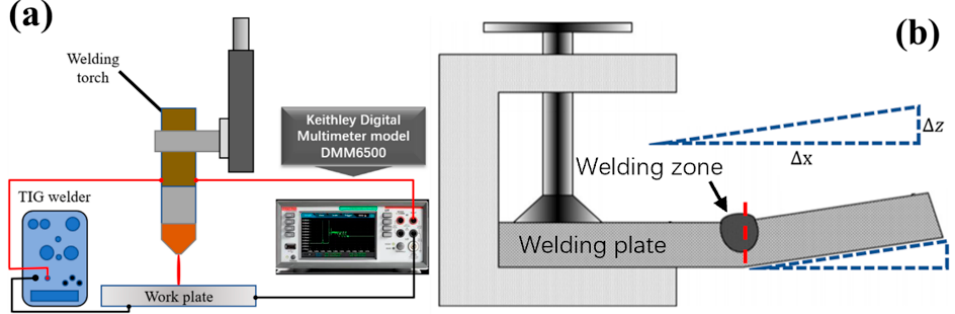
Figure 3. Measurement configurations for ( a ) arc voltage and ( b ) angular distortion of TIG weldment. The schematic for the angular distortion measuring setup is shown in Figure